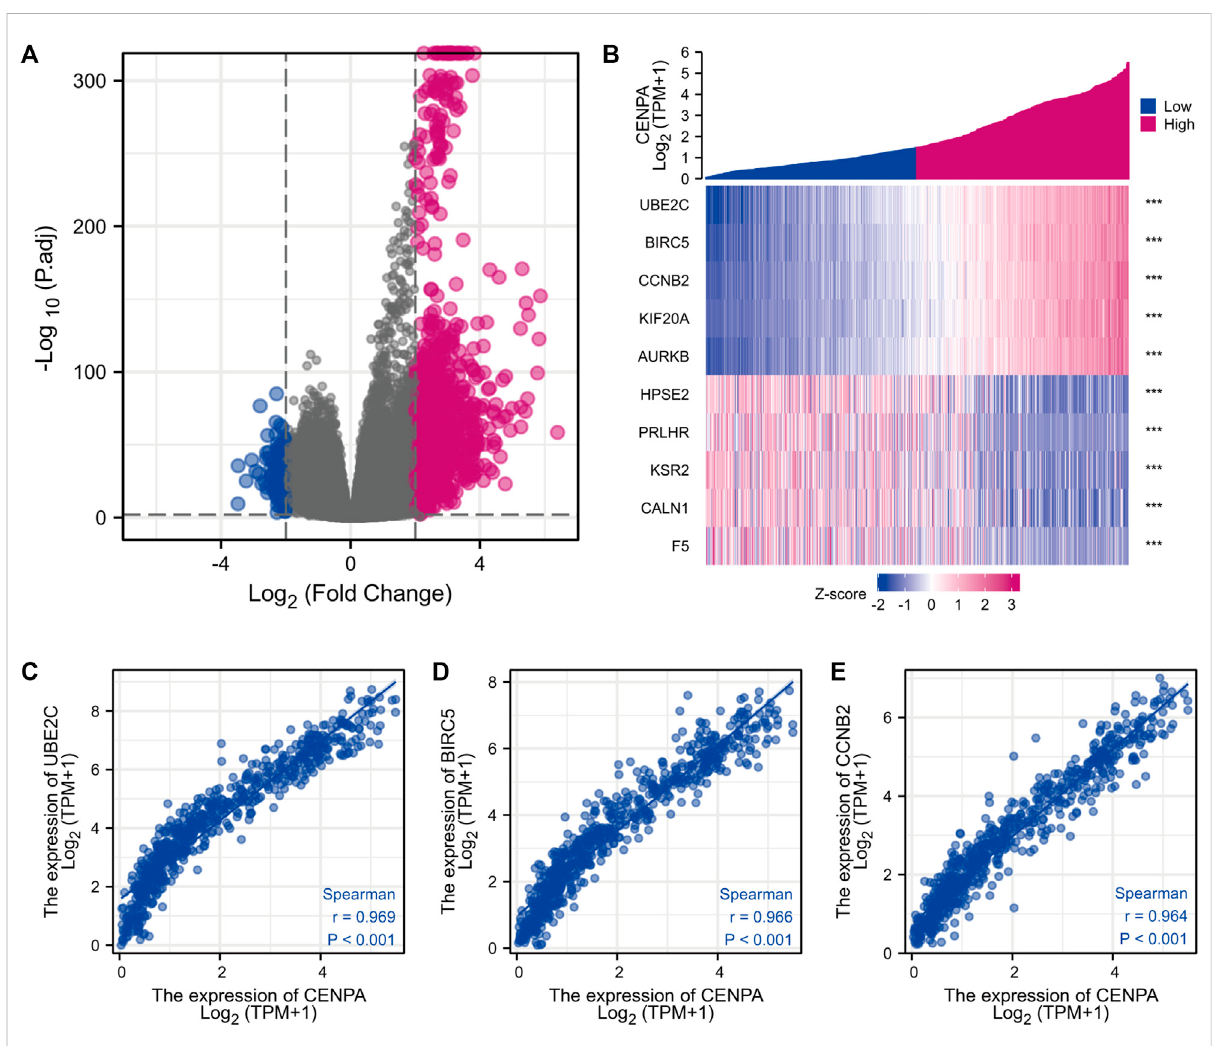
FIGURE 5 Differentially expressed genes (DEGs) between high and low CENP-A expression glioma groups in TCGA dataset. (A) Heatmap of the top fi ve upregulated and downregulated DEGs. (B) Volcano plot of DEGs expression pro fi les. (C – E) Scatter plot showing the correlation between CENP-A expression and UBE2C (C), BIRC5 (D), and CCNB2 (E)